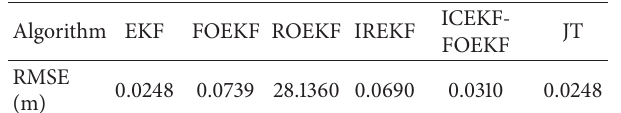
Table 2: RMSE of all algorithms at the end of